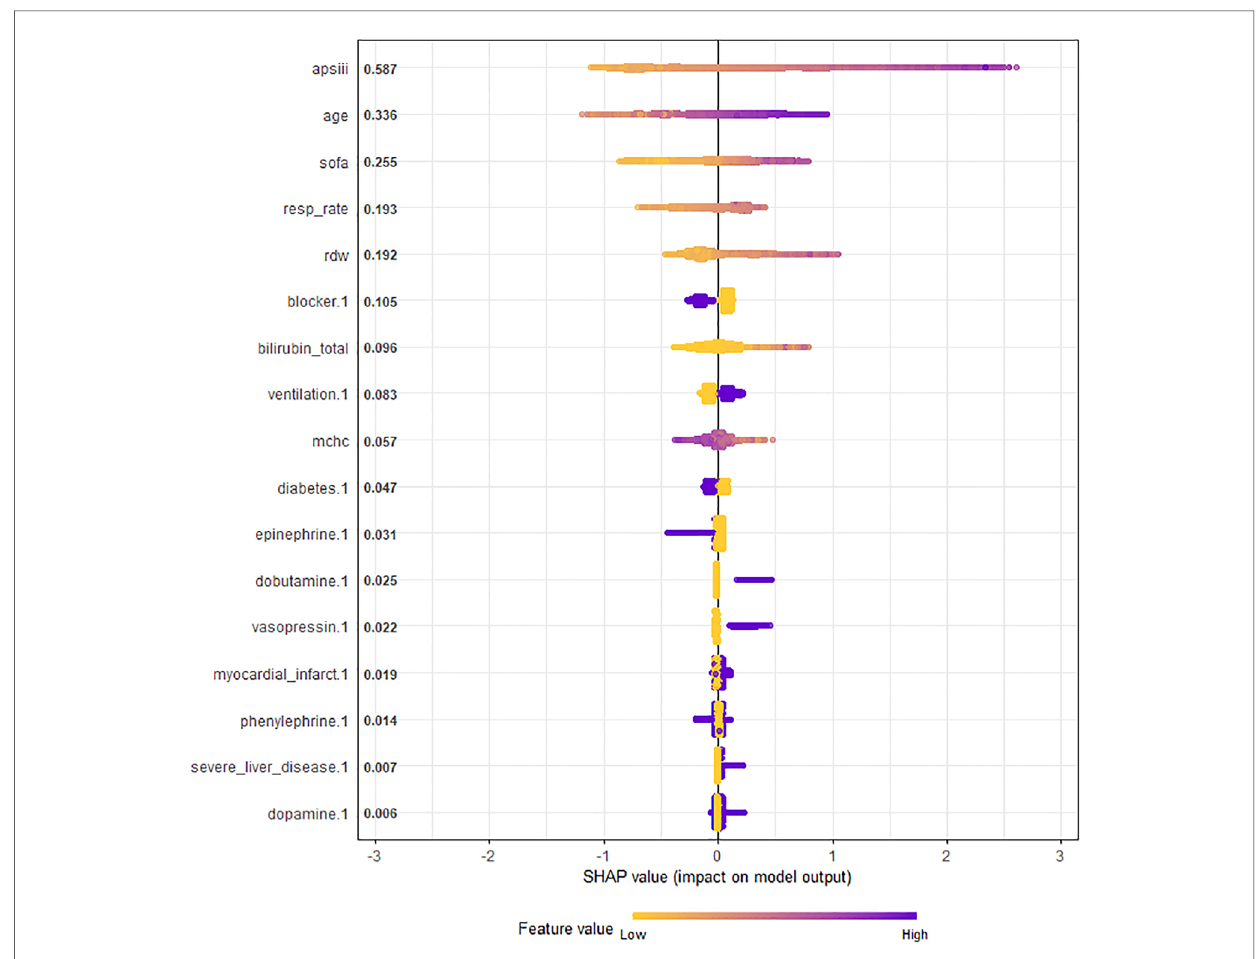
FIGURE 3 Chart of feature importance ranking in all ICU patients with congestive heart failure. The importance ranking of the 17 risk factors with stability and interpretation using the optimal model in the training set. Each point in the graph represents the SHAP value for each sample; a color month closer to purple indicates a larger value, while that closer to yellow indicates a smaller value. The more scattered the points in the graph, the greater the in fl uence of the variable on the model. APS III, age and SOFA were strongest predictors. SHAP, SHapley additive exPlanations; SOFA, sequential organ failure assessment; APS III, acute physiology score III scores; MCHC, mean corpuscular hemoglobin content; RDW, red blood cell distribution